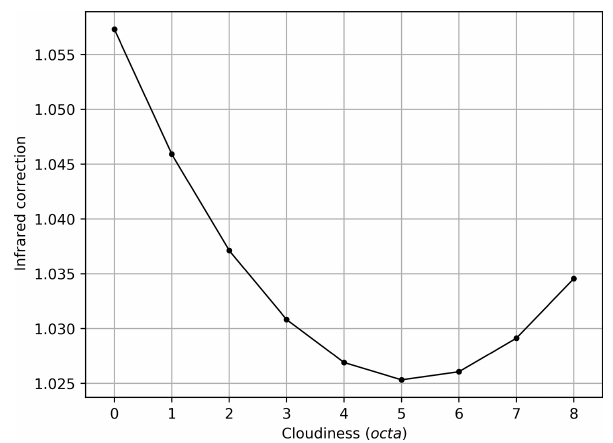
Figure A1. Infrared correction as a function of